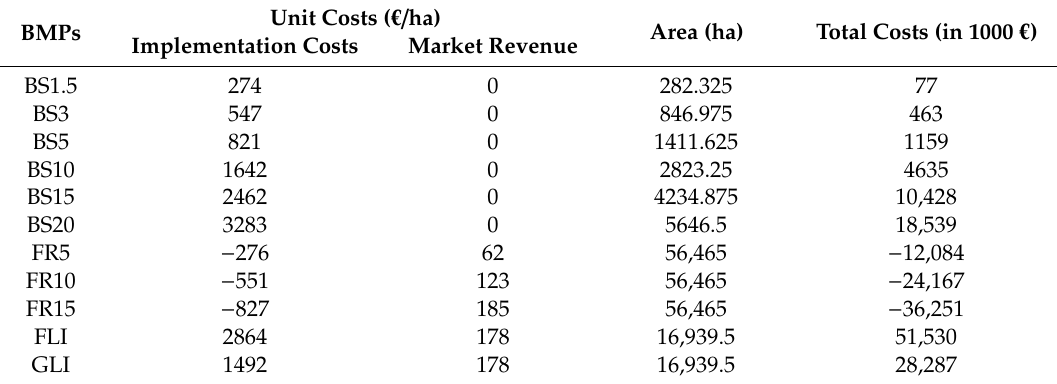
Table 3. Total costs of BMPs implementation in 1000 € for the